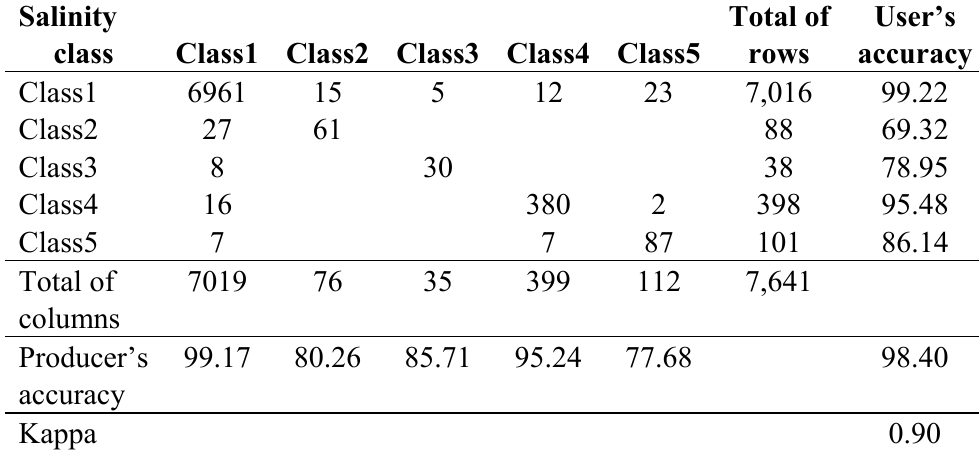
Table 5. Producer’s, user’s, overall accuracy and Kappa coefficient for predicted soil salinity classes developed without